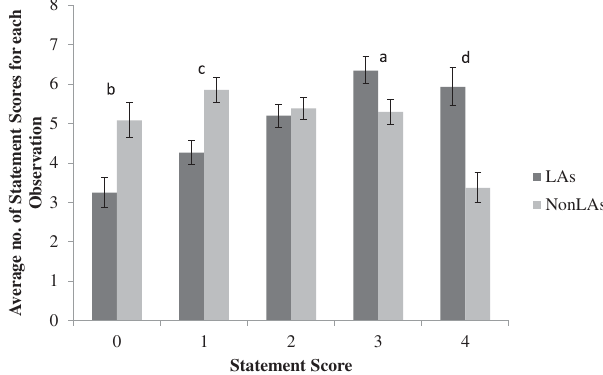
FIG. 5. Analysis of all RTOP responses for LAs and NonLAs using statement score counts. Error bars represent plus and minus 1 standard error on the mean. (a) p ¼ 0 . 02 , (b) p ¼ 0 . 002 , (c) p ¼ 0 . 0004 , (d) p ¼ 0 . 00002